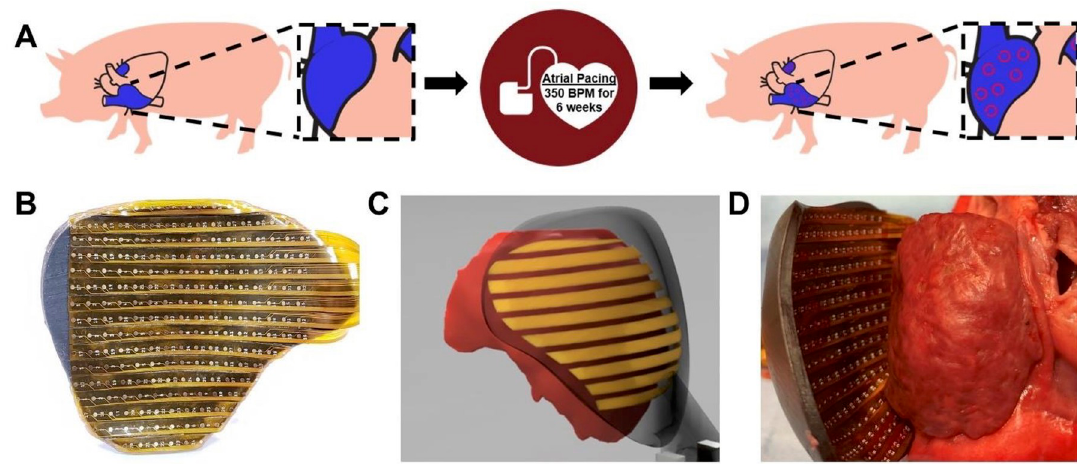
Fig 1. Persistent AF experimental design and electroanatomic mapping. (A) Persistent AF swine underwent cardiac pacemaker insertion and animals were rapidly paced at 350 bpm for six weeks to induce AF. (B) Flexible epicardial mapping devices were custom fabricated from animal specific cardiac magnetic resonance imaging. (C-D) Custom gold-plated flexible electrode arrays were mounted onto 3D printed epicardial shells to create a functional mapping